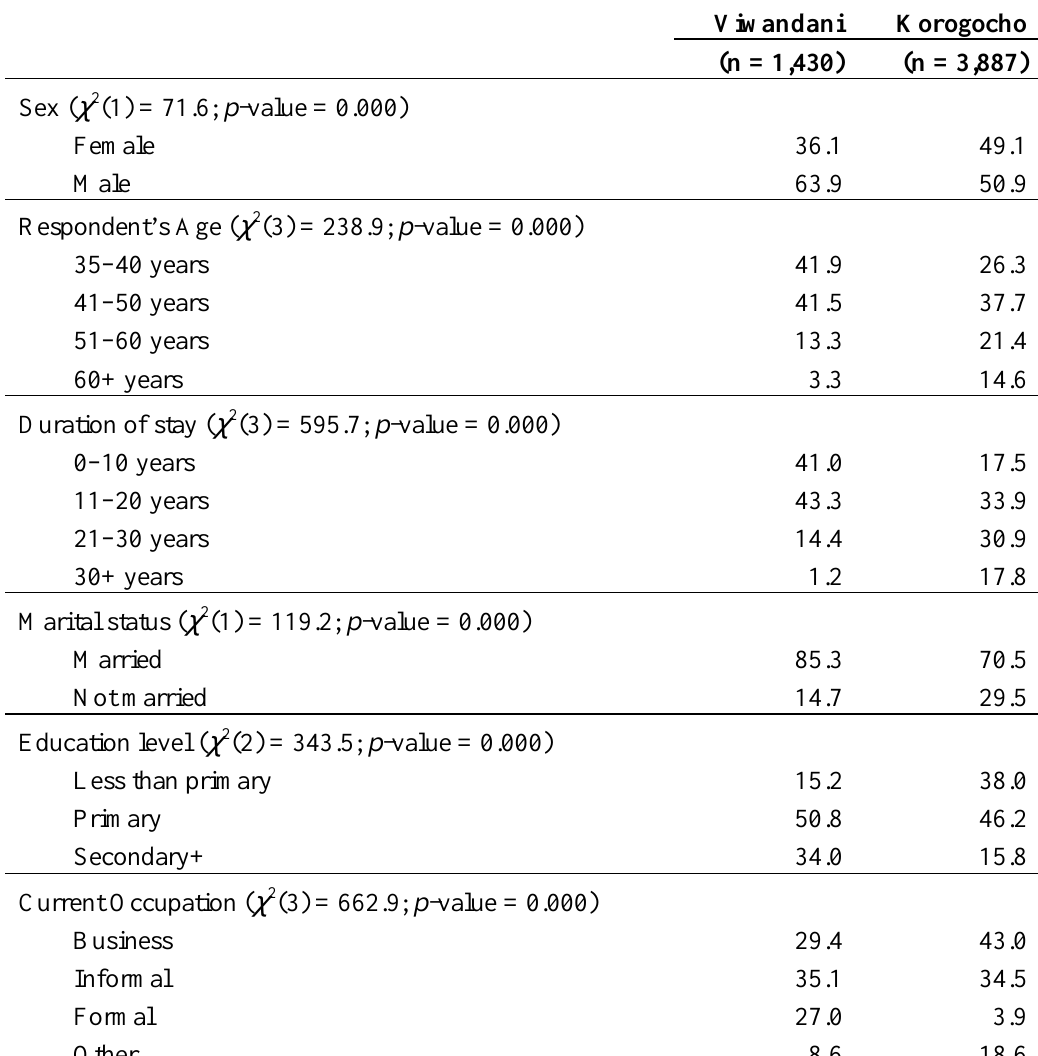
Table 2. Percentage distribution of the study sample by the two study sites.